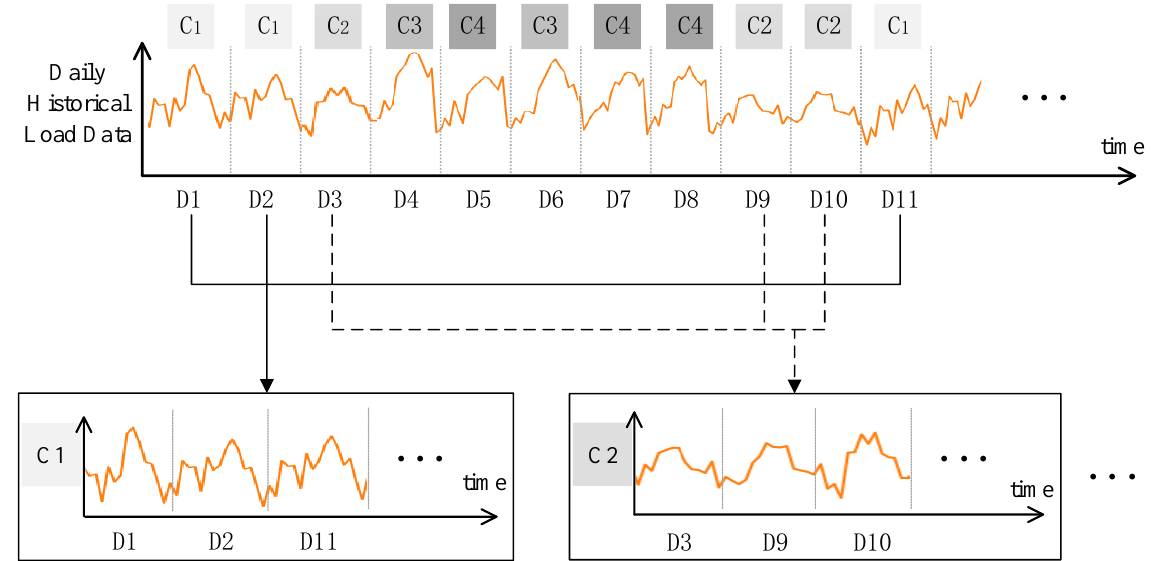
Figure 1. Construct time series of historical load data for each